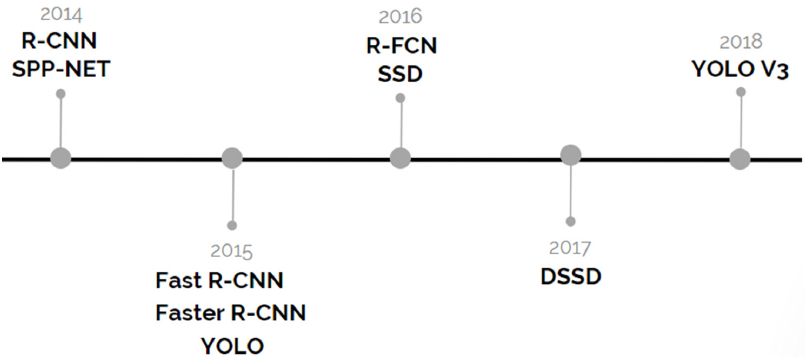
Figure 9. Timeline development of CNN-based detectors. R-FCN: Region-Based Fully Connected Convolution Network.